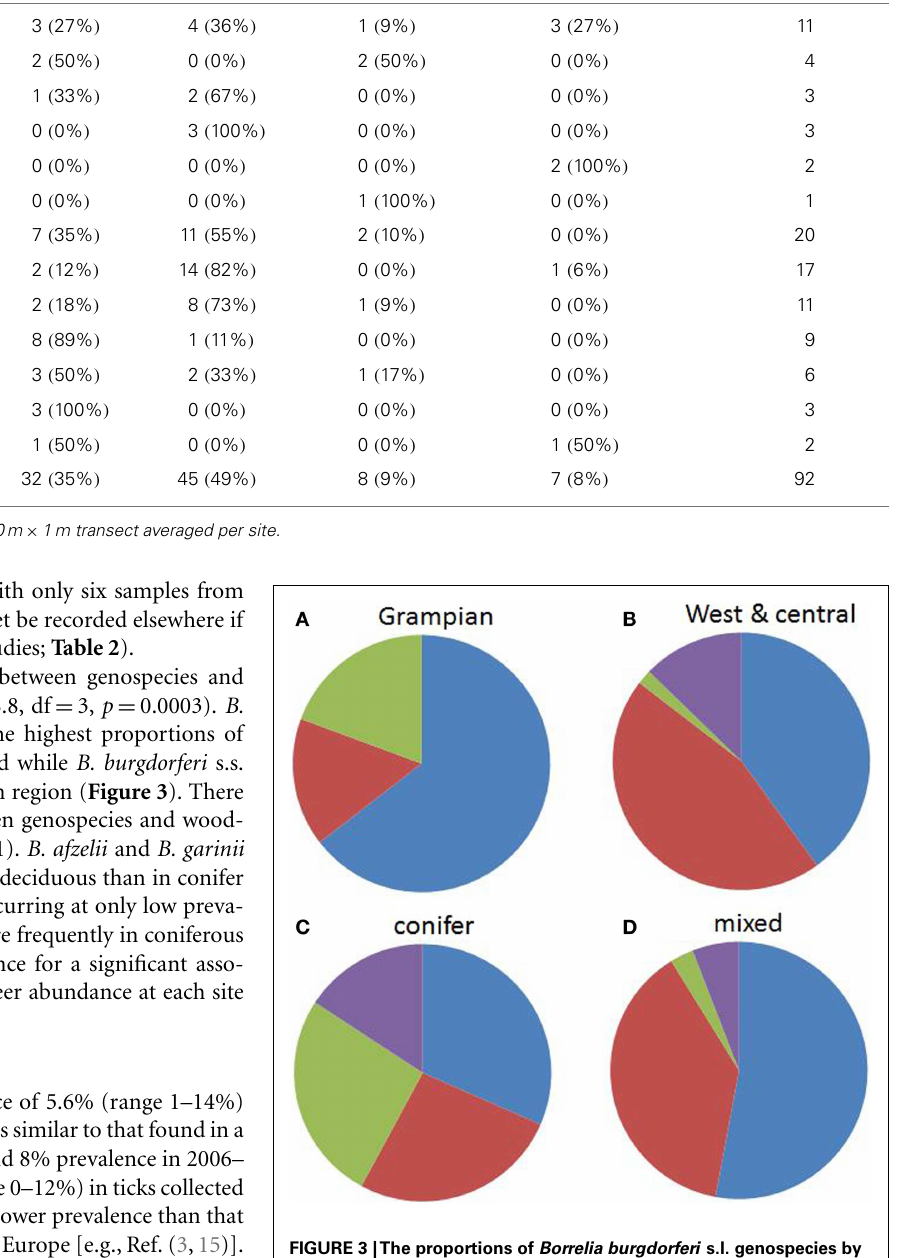
although Ref. (15) found B. afzelii at around half of their